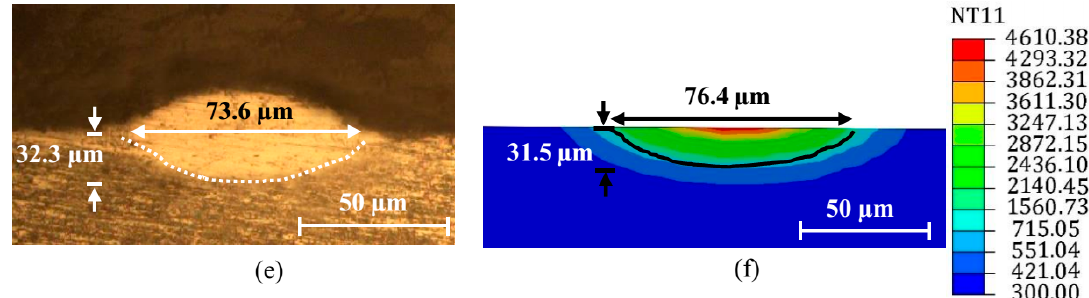
Figure 4. Cross-sectional views of the experimental and numerical models: ( a , b ) pure AISI 304; ( c , d ) 3 wt% Al 2 O 3 ; ( e , f ) 3 wt% Al 2 O 3 -ZrO 2 . (NT11: Nodal Temperature).